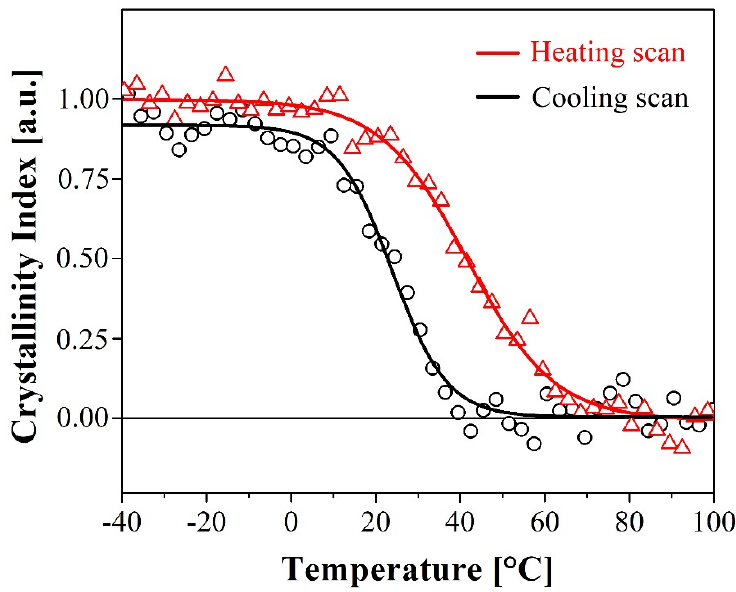
Figure 5. Evolution of synchrotron WAXD-based crystallinity index of bitumen A during cooling and heating, where dots are experimental data points and full lines are sigmoidal guides.